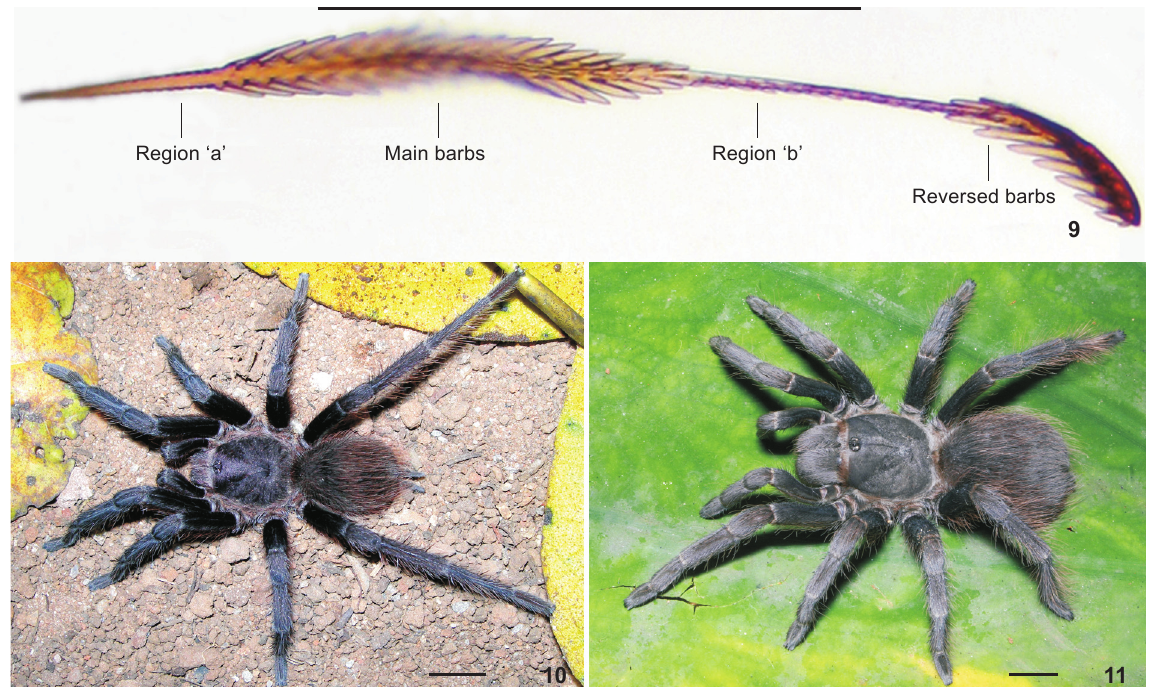
Figures 9-11. Vitalius nondescriptus comb. nov. : (9) holotype male: urticating hair type I; (10) male MZSP 465161;(11) female MZSP 465351. Both from Ouro Preto, state of Minas Gerais, Brazil. Photos: (9) R. Bertani, (10) C.S. Fukushima, (11) R. Bertani. Scale bars = 9 = 0.25 mm, 10-11 = 10 mm.